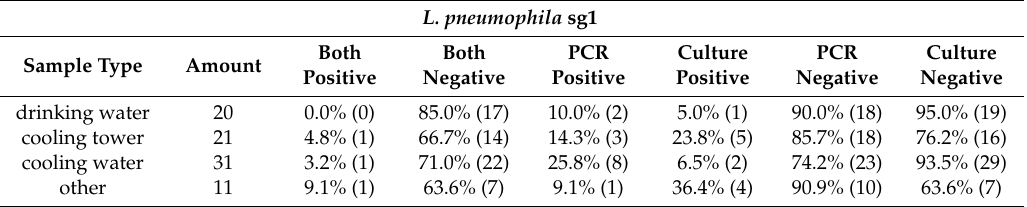
Table 3. Detection of L. pneumophila sg1 via culture and qPCR ( wzm gene).